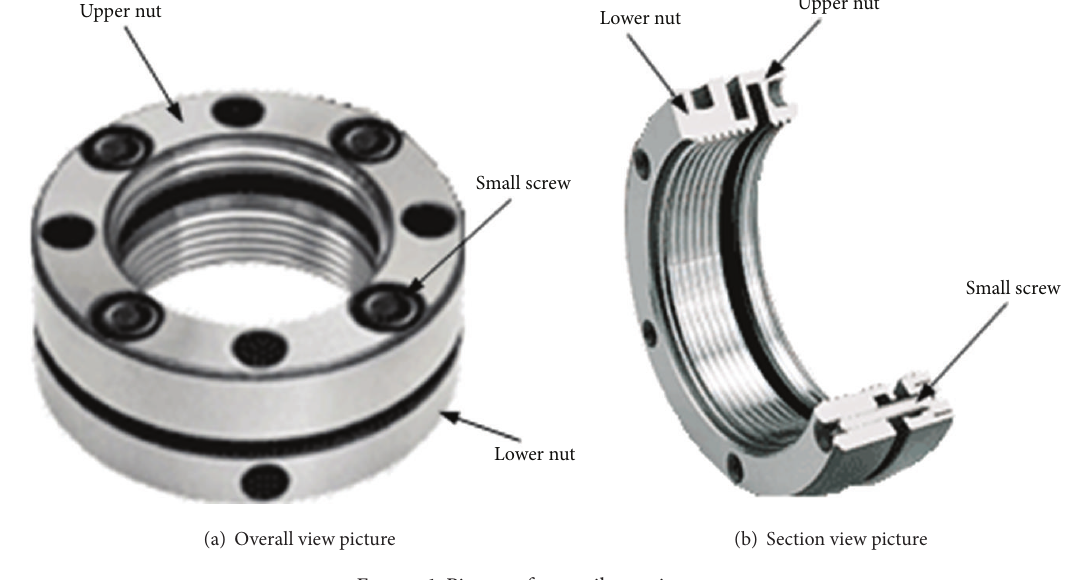
Figure 1: Picture of an antiloosening nut.